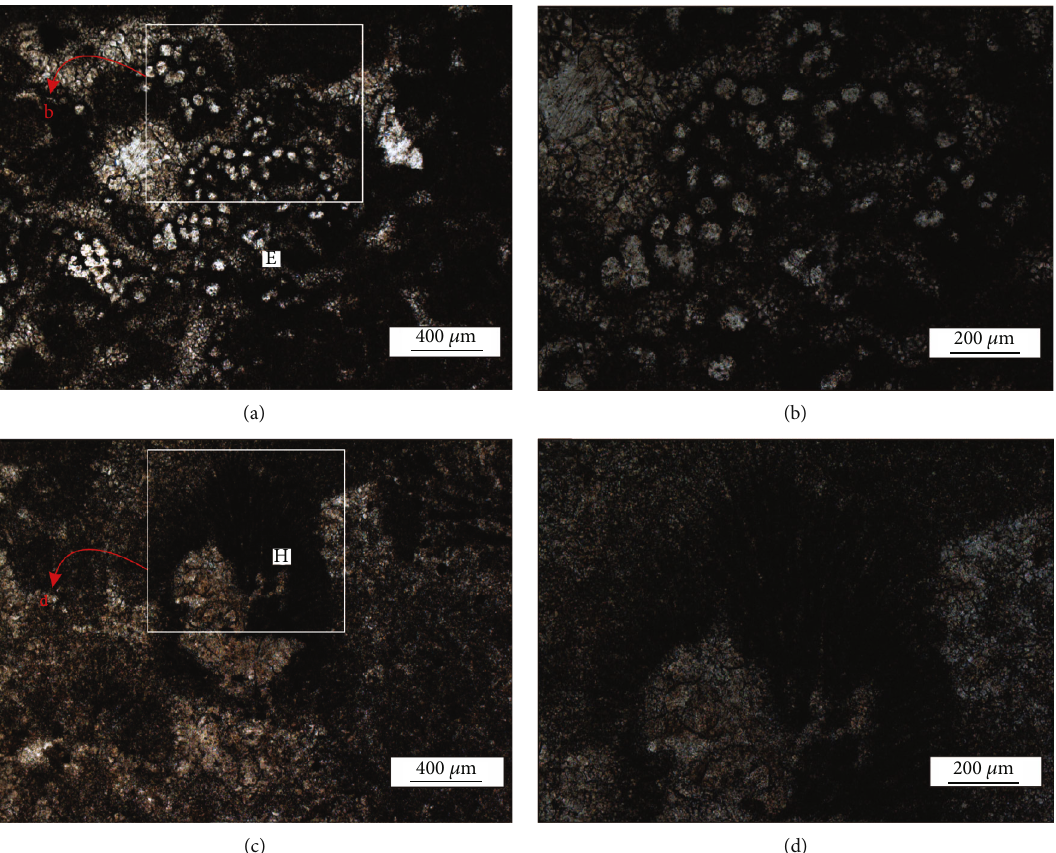
Figure 8: Micrograph of symbiosis of calci fi ed cyanobacteria fossils in dendrolite rocks of Zhangxia Formation in Houziyu section. (a, b) Sparry coarse Epiphyton (E) forming sparry dendrolite communities. (b) The enlarged photo of the box area in (a), and a clear hollow tube wall can be seen. (c, d) Typical Hedstroemia (H). (d) The enlarged photo of the boxed area in (c). It can be seen that the branches diverge from one point and grow outwards, and the branches are long and tapering at the tip, basically without